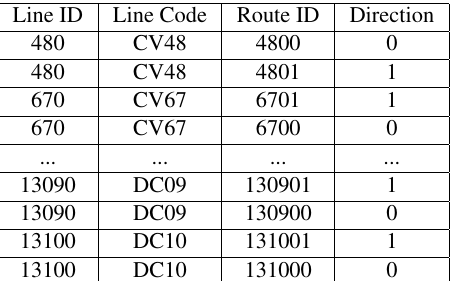
Table 1: Line and Route Relation Samples Line ID Line